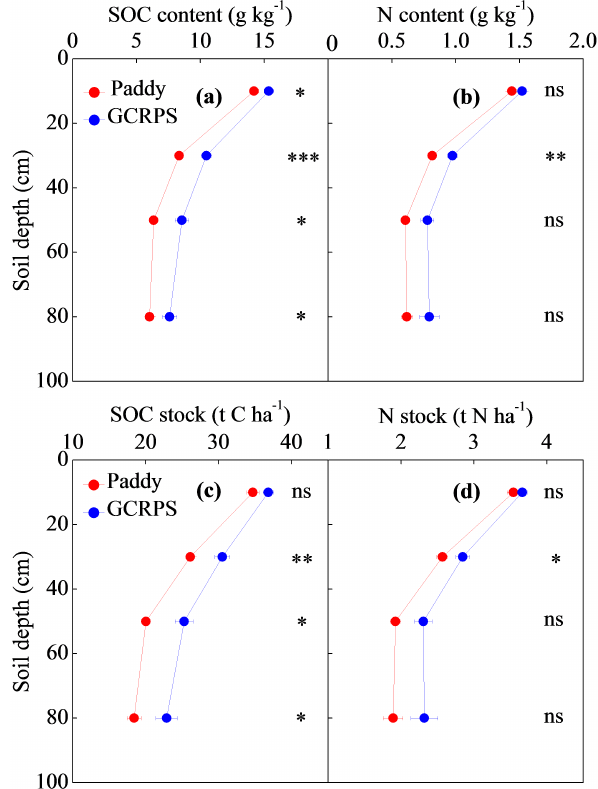
Figure 1. Concentrations and stocks of soil organic carbon and to- tal nitrogen in traditional paddy fields and GCRPS at different soil depths. Data presented are the mean values pooled over 49 paired sites (for 0–20 and 20–40cm, n is 147; for 40–60cm, n is 108; and for 70–90cm, n is 63). Errors bars indicate the standard error of the means. ∗∗∗ , ∗∗ , and ∗ denote significance at 0.001, 0.01, and 0.05 probability levels, respectively. Values that are not significant are denoted by ns .